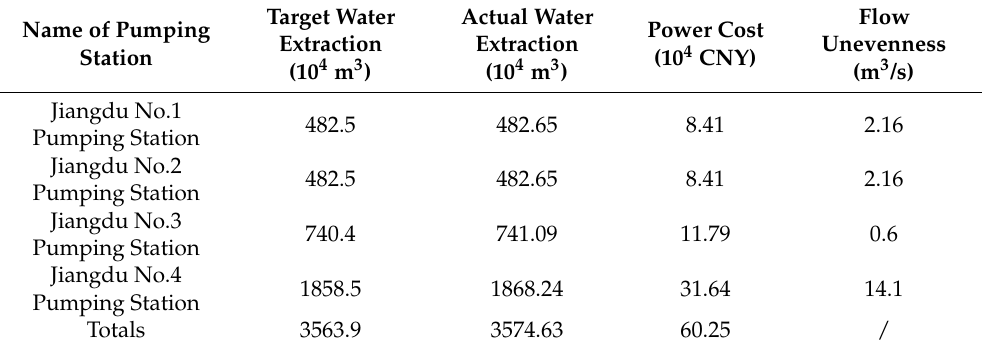
Table 4. Optimization results of a large-scale system aggregated model under daily head 7.8 m with 80% water extraction